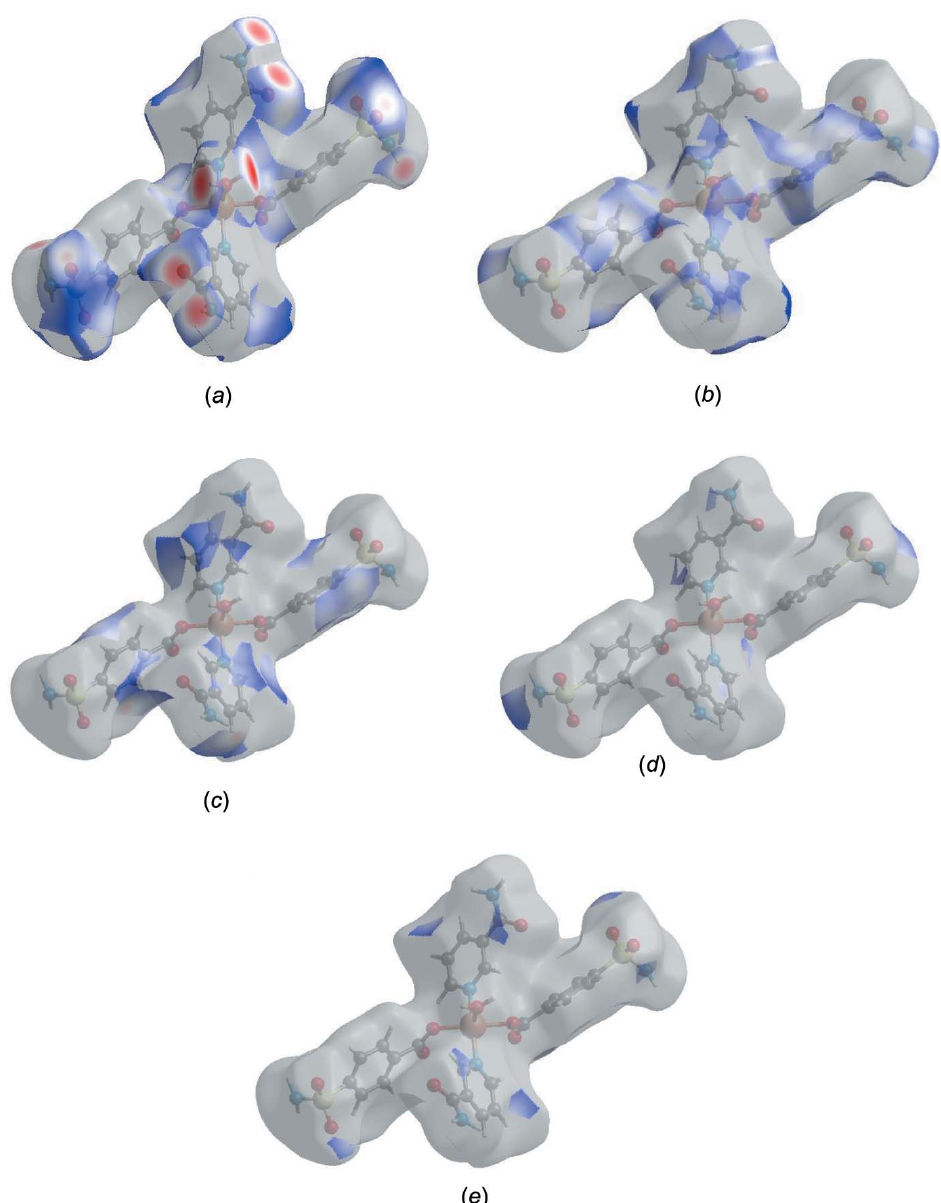
Figure 6 Representations of the Hirshfeld surface with the function d norm plotted onto the surface for ( a ) H (cid:2)(cid:2)(cid:2) O/O (cid:2)(cid:2)(cid:2) H, ( b ) H (cid:2)(cid:2)(cid:2) H, ( c ) H (cid:2)(cid:2)(cid:2) C/C (cid:2)(cid:2)(cid:2) H, ( d ) H (cid:2)(cid:2)(cid:2) N/ N (cid:2)(cid:2)(cid:2) H and ( e ) O (cid:2)(cid:2)(cid:2) C/C (cid:2)(cid:2)(cid:2) O contacts with distances equal to the sum of van der Waals radii, and the red and blue colours indicate distances shorter (in close contact) or longer (distinct contact) than the van der Waals radii, respectively (Venkatesan et al. , 2016). The bright- red spots appearing near SB-O1, SB-O4, NA-O5 and hydrogen atoms H21, H31, H32 and H61 indicate their role as the respective donors and acceptors in the dominant O— H (cid:2) (cid:2) (cid:2) O and N—H (cid:2) (cid:2) (cid:2) O hydrogen bonds; they also appear as blue and red regions, respectively, corresponding to positive and negative potentials on the HS mapped over electrostatic potential (Spackman et al. , 2008; Jayatilaka et al. , 2005) as shown in Fig. 4. The blue regions indicate the positive elec- trostatic potential (hydrogen-bond donors), while the red